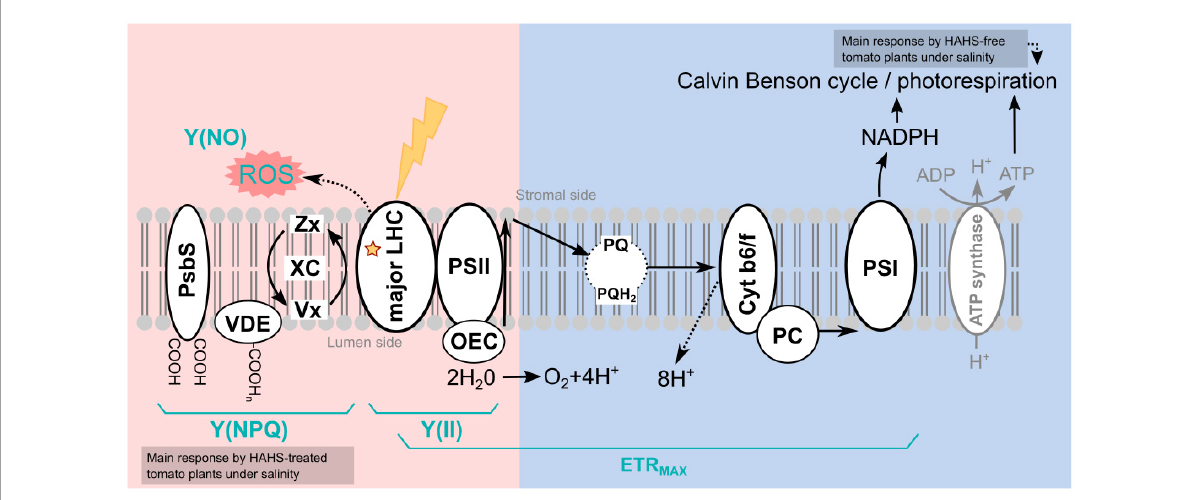
FIGURE8 Model of habitat-adapted heterologous symbiont (HAHS)-induced changes in the light reactions of photosynthesis and associated alternative electron transfer pathways. The light energy distribution (pink side) and electron transport (blue side) of the light reactions of photosynthesis are shown. In the control plants, the photochemical energy flows to NADPH, mainly via the linear electron flow (LEF) pathway. Reduced Y(NO) and increased Y(II) indicate a lower probability of non-regulated dissipation but a higher probability of energy conduction to photochemistry as observed for HAHS-treated plants. As a result, plants exhibited higher F V /F M values and high plant growth. An increase in Chl content, the Chl a / b ratio, and beta-carotene but a reduction of XC/Chl a + b suggests a reduction of antenna size and an increase of PSII reaction centers in agreement with the increase in photosynthetic performance. High ETR MAX with a small antenna and no PSII damage indicates highly efficient energy consumption in the Calvin cycle induced by HAHS interaction. Plants under salt stress without HAHS did not exhibit differences in Y(NO) or Y(NPQ) dissipation, indicating that no induced protective mechanism was present in the antenna. However, a significant increase in Y(II) linked to lower plant size was found, suggesting that a salt-induced mechanism in tomato plants without HAHS is related to the activation of alternative sinks such as photorespiration. Induced stomatal closure due to saline stress reduces CO 2 /O 2 ratio increases the photorespiration probability. Photorespiration reduces the energy destined for photosynthetic Calvin Benson cycle, thereby affecting plant growth. In plants treated with HAHS under saline conditions, the HAHS protects plant photosynthesis by increasing the regulated thermal energy dissipation Y(NPQ) pathway, which decreases the potential for ROS formation in the LHCII antenna. This is also reflected in high F V /F M values compared to those of the control and control + NaCl plants. PsBS, pigment-binding protein associated with photosystem II (PSII); VDE, Violaxanthin De-Epoxidase; XC, Xanthophyll cycle pigments (Zx+Ax+Vx); Zx, Zeaxanthin; Ax; Antheraxanthin, Vx, Violaxanthin; LHC, Light-Harvesting Complex; PSII, Photosystem II; OEC, oxygen-evolving complex; PQ, Plastoquinone; PQH, Plastoquinol; AOX, Alternative Oxidase; Cyt b6/f, Cytochrome b6/f; PC, Plastocyanin; PSI, Photosystem I; ROS, Reactive oxygen species; ETR MAX , Maximum electron transfer rate;